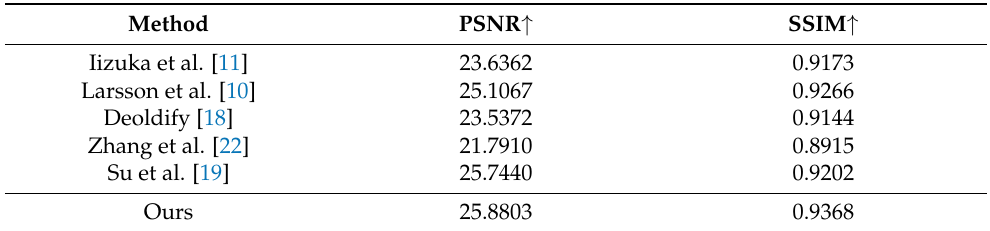
Table 2. Quantitative analysis of colorization effect. As compared with the PSNR and SSIM values of other colorization algorithms, the colorization effect of our network is